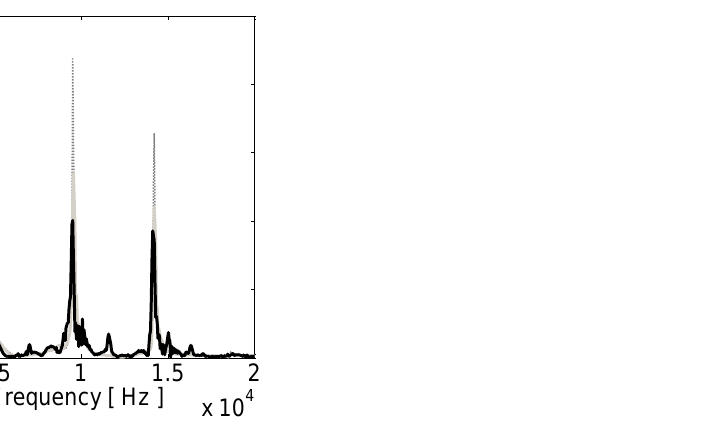
Figure 10. Time history of the computed axial stress.